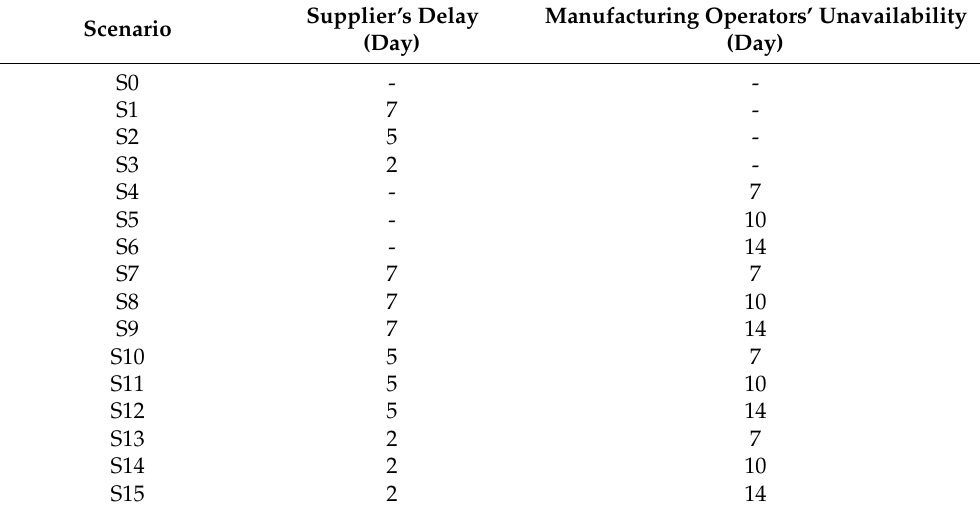
Table 2. Scenarios for assessment of impacts related to COVID-19.